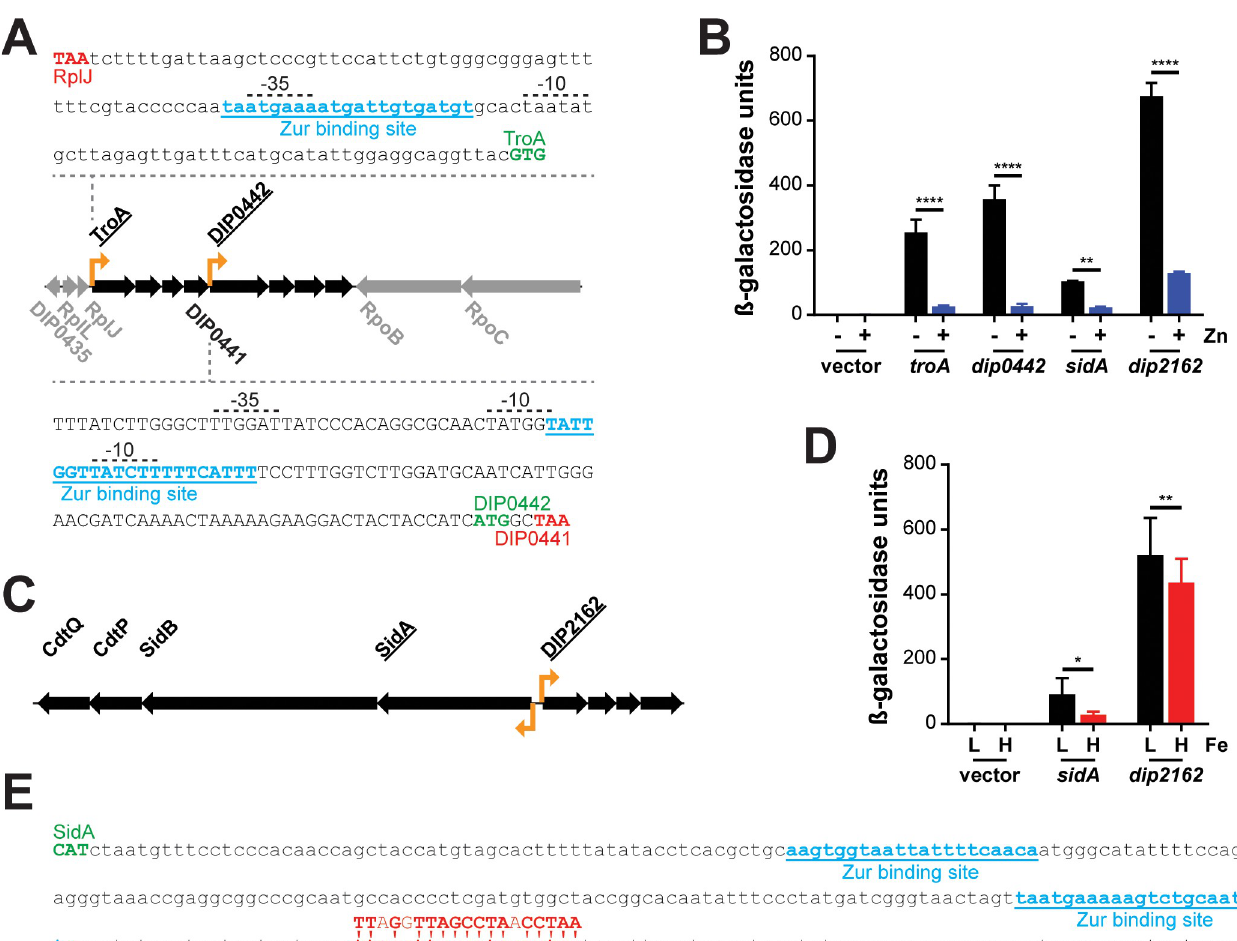
Fig 3. Zinc regulated promoters of troA ( dip0438) , dip0442 , sidA ( dip2161) , and dip2162 . (A) Genes of the troA-dip0445 gene locus encode a putative ABC transport system and several membrane proteins of unknown function. Flanking genes encode ribosomal proteins and components of RNA polymerase (RpoB and RpoC) (grey). DNA sequence of the promoter regions for troA (top) and dip0442 (bottom) with notable features are shown: Zur binding sites (blue), start codons (green), stop codons (red), and predicted -10 and -35 elements (promoter elements were not experimentally determined, but based on the consensus sequences determined previously [15].Coding regions are uppercase, while non-coding regions are lowercase. (B) Promoter fusions for troA , dip0442 , sidA , and dip2162 were tested for activity in mPGT without ( - ) and with ( + ) zinc supplementation (5 μ M), n = 3. (C) Genes of the dip2158 ( cdtP ) -sidA region encode a putative yersiniabactin-transport ( cdtPQ ) and synthesis ( sidAB ) like locus that is adjacent to a putative ABC transporter ( dip2162-dip2165 ). (D) Promoter fusions for sidA and dip2162 were tested for activity in mPGT with low ( L )(0.5 μ M) and high ( H )(10 μ M) iron supplementation in the absence of added zinc; n = 4. The data are the mean and standard deviation of indicated biological replicates for each experiment. All data were analyzed by 2way ANOVA, Holm-Sidak: ���� indicates p < 0.0001, �� indicates p < 0.01, and � indicates p < 0.05. (E) DNA sequence of the sidA-dip2162 intergenic region. Notable features are indicated: Zur binding sites (blue), DtxR binding site (red) with consensus DtxR binding site above (red) and start codons (green).